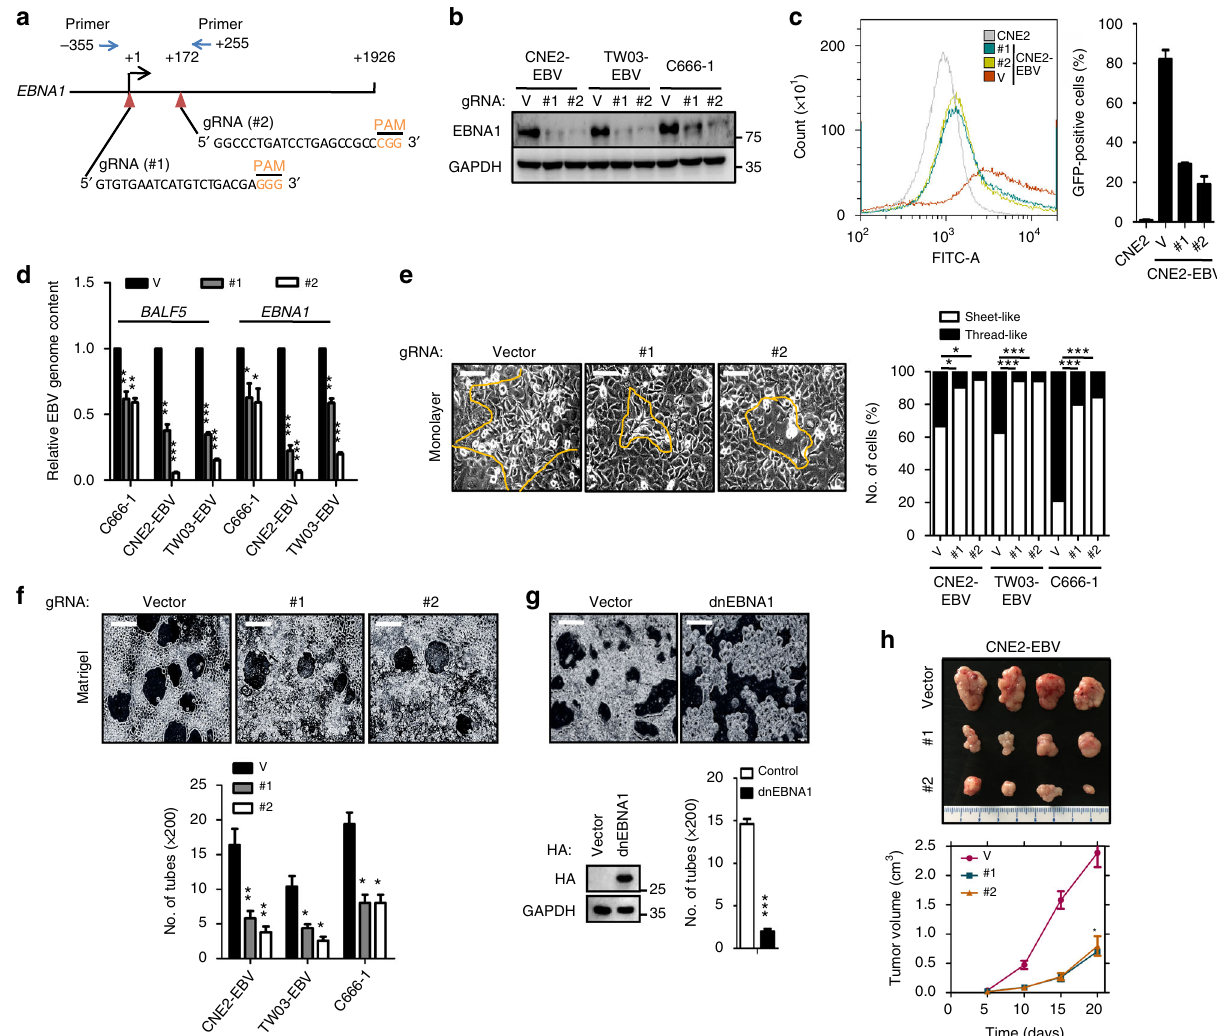
Fig. 2 Clearance of EBV genomes reduces VM formation. a Schematic representation of the EBNA1 gene and its gRNA target sites. Primers for T7E1 assay are shown (see Supplementary Fig. 2a). b Western blot analysis of EBNA1 in NPC-EBV cells transduced with control lentivirus or lentivirus expressing two EBNA1 gRNAs. c CNE2-EBV cells carrying recombinant EBV-GFP virions were subjected to CRISPR/Cas9-mediated EBV targeting as in b , and the GFP expression was determined by fl ow cytometry. Mean ± SD, n = 2. d Relative EBV copy numbers in NPC-EBV cells infected with control lentivirus or lentivirus carrying EBNA1 gRNAs, as determined by real-time PCR using primers directed to BALF5 and EBNA1 . Data are represented as the mean ± SD, n = 3, two-tailed paired t -test. e (left) Images of TW03-EBV cells transduced with control lentivirus or lentivirus expressing EBNA1 gRNAs grown in conventional 2D culture plates. Scale bars = 100 μ m. (right) Proportions of sheet-like and thread-like cell types were determined by microscopy with 200× magni fi cation in randomly chosen fi elds. Mean ± SD, n = 5, two-tailed unpaired t -test with Welch ’ s correction. f (top) Images of the cells as in e , grown on 3D Matrigel. Scale bars = 50 μ m. (bottom) Quanti fi cation of the tube numbers. Tubes were counted under a microscope with 200× magni fi cation. Mean ± SD, n = 5, two-tailed Mann – Whitney test. g Tube formation of CNE2-EBV cells transfected with empty vector or HA-tagged dominant-negative EBNA1 mutant (dnEBNA1). Mean ± SD, n = 5, two-tailed paired t -test. h (top) Images of xenografts formed by CNE2-EBV cells transduced with lentiviral vector or lentivirus expressing EBNA1 gRNA #1 or #2 at day 20 post-implantation. (bottom) Growth curves of xenografts formed by parental CNE2-EBV cells